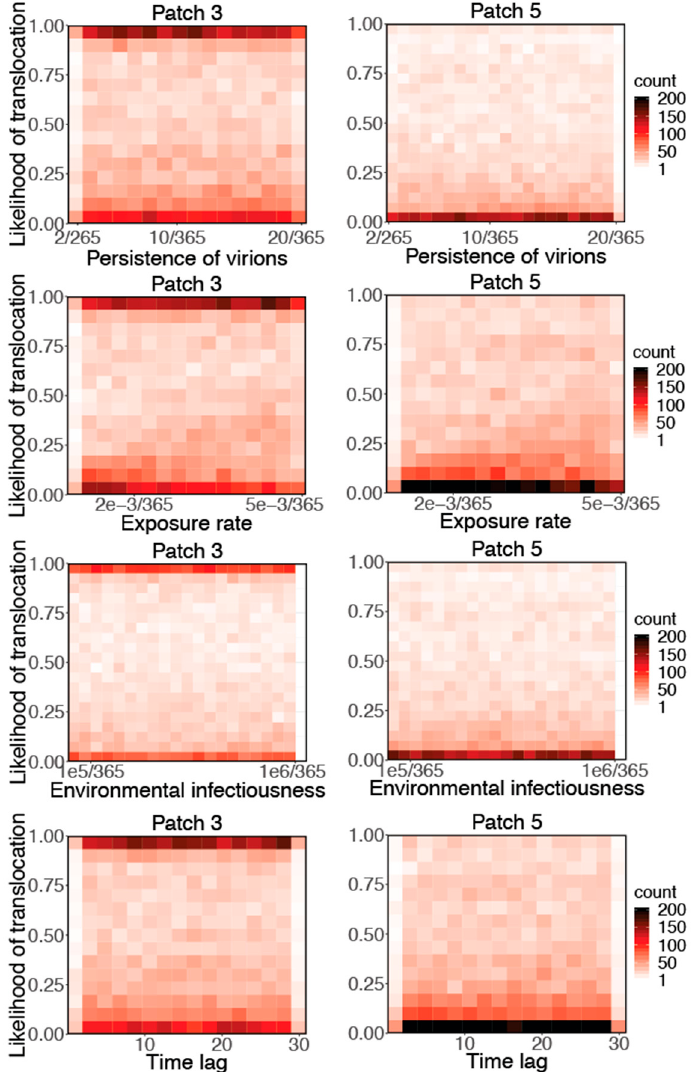
Figure 3. The marginal distribution of the likelihood of the virus reaching Patch 3 and Patch 5 for each of the three environmental transmission parameters: 1) Persistence of virions; 2) exposure rate; and 3) environmental infectiousness; and the migration start time lag between the two flocks. The color gradient represents the number of parameter combinations within each pixel.